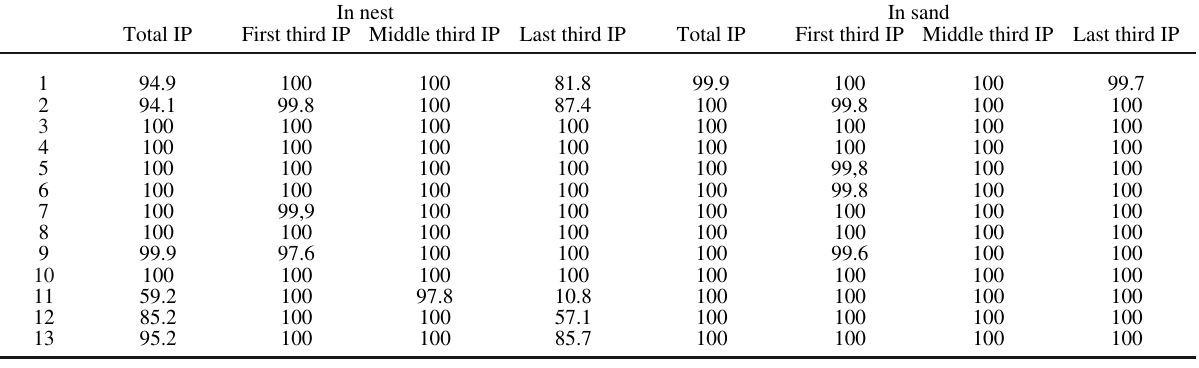
Table 4. – Mean humidity in studied nests and adjacent sand (control) during different incubation periods. IP, incubation period. In nest In sand Total IP